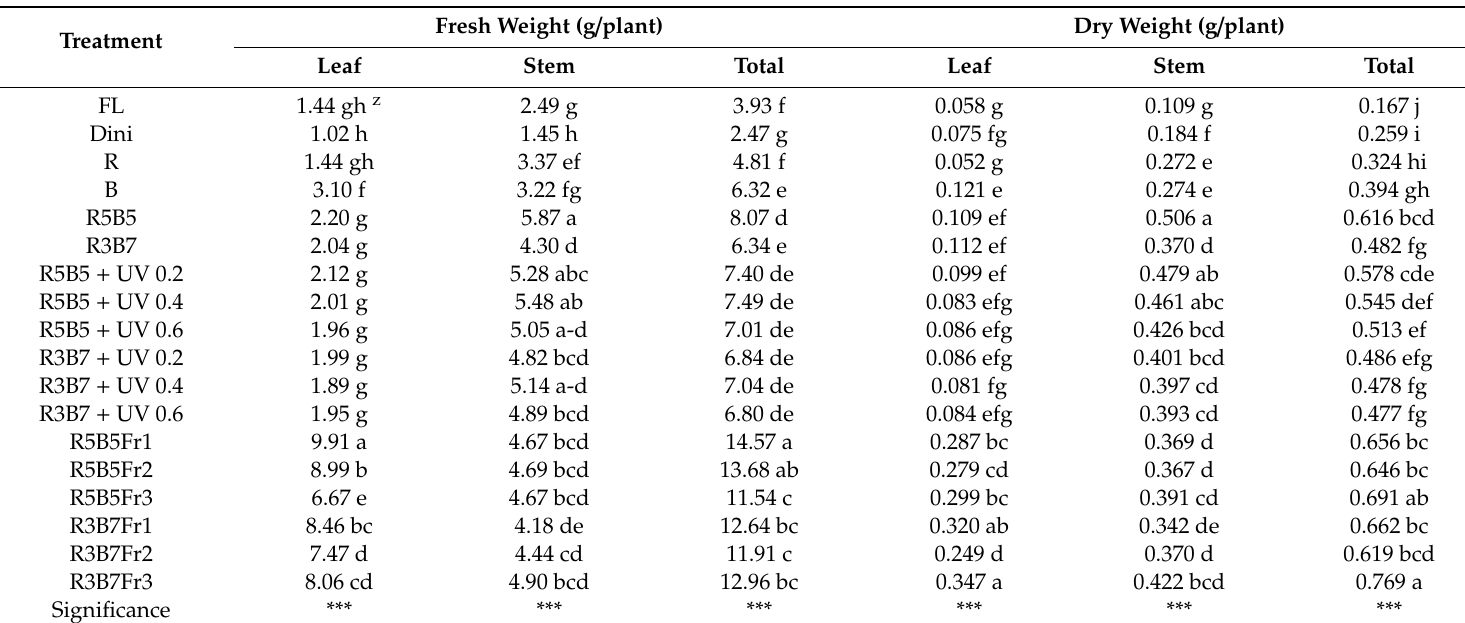
Table 3. The e ff ects of the light quality on fresh and dry weights of leaf and stem of “Joeunbaekdadagi” cucumber ( Cucumis sativus L.) measured at 22 days after